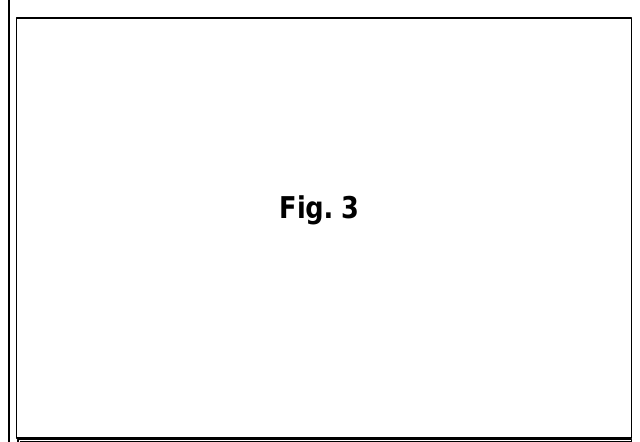
Fig. 3 : Invasion of malignant melanoma cells with melanin into the parotid acini. Main tumour is seen on one side. H & E X